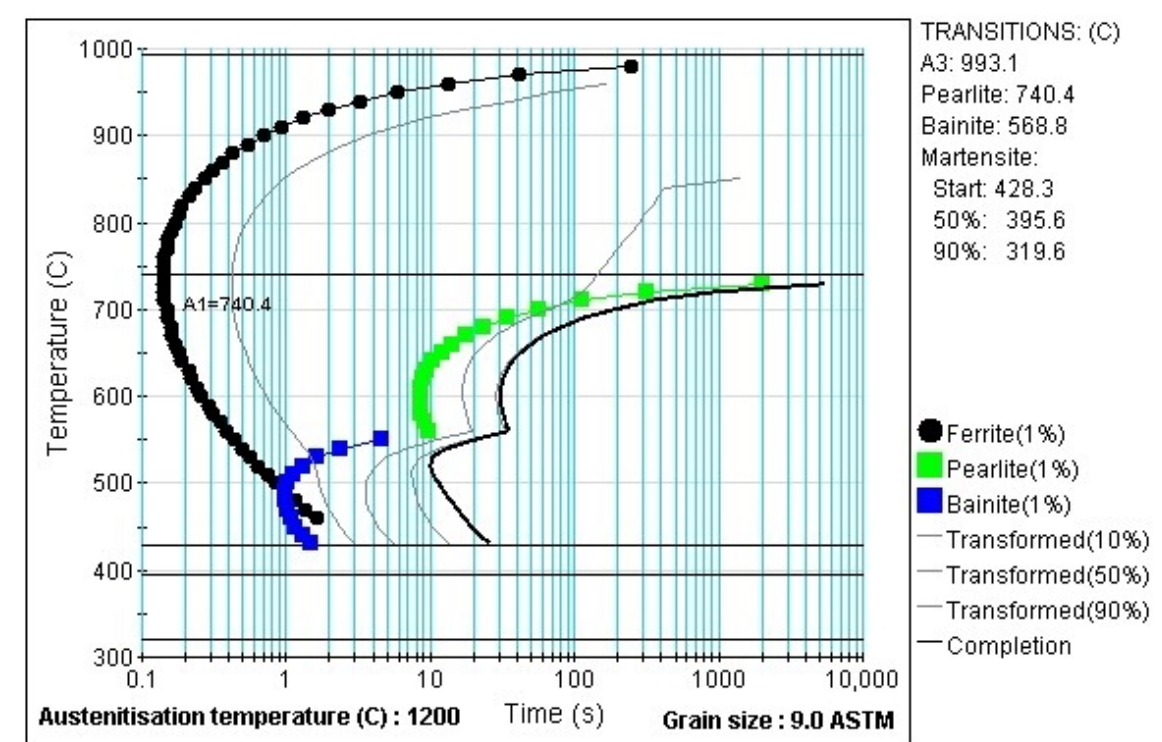
Figure 15. TTT diagram for 20MnAl steel calculated in JMatPro software.